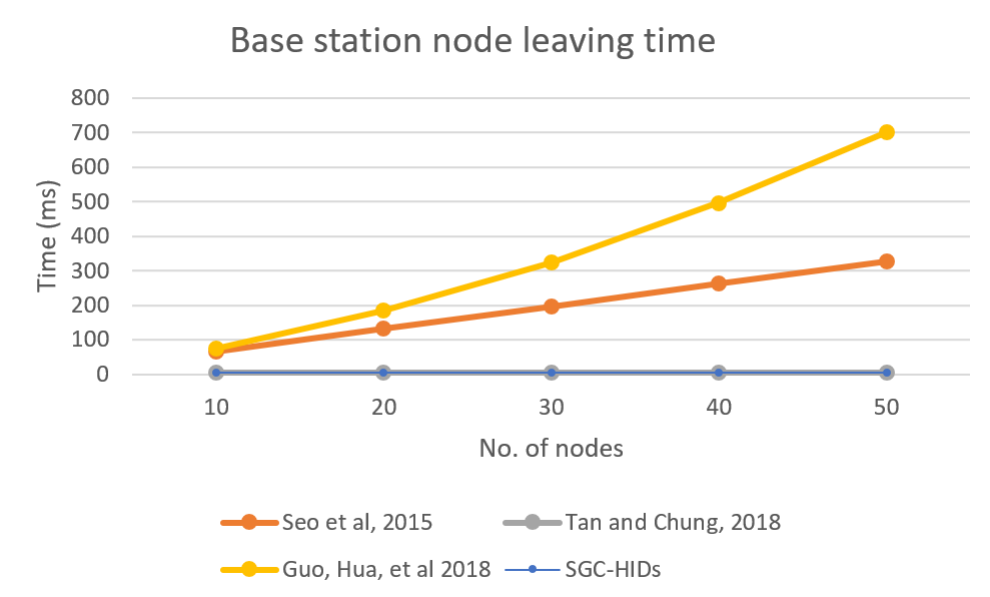
Figure 12. Base station computation time needed for node leaving the